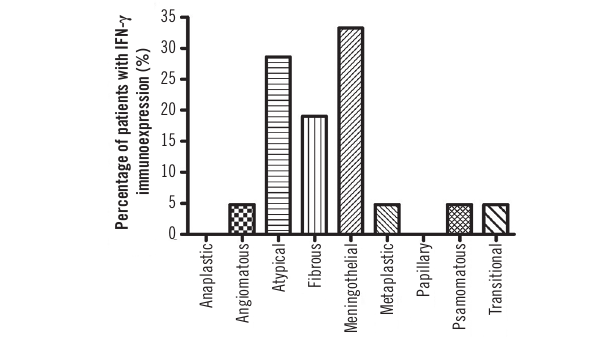
figure 3 – IFN- γ immunoexpression in the morphological subtypes of